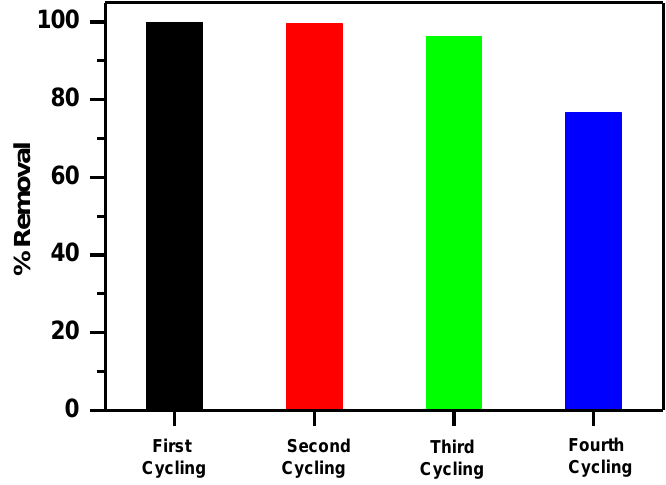
Figure 13. Efficiency of recycled MNS-4 for removal of MB.